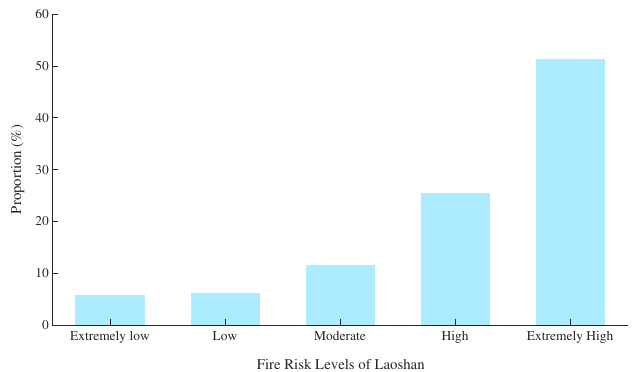
Figure 15. Forest fire risk